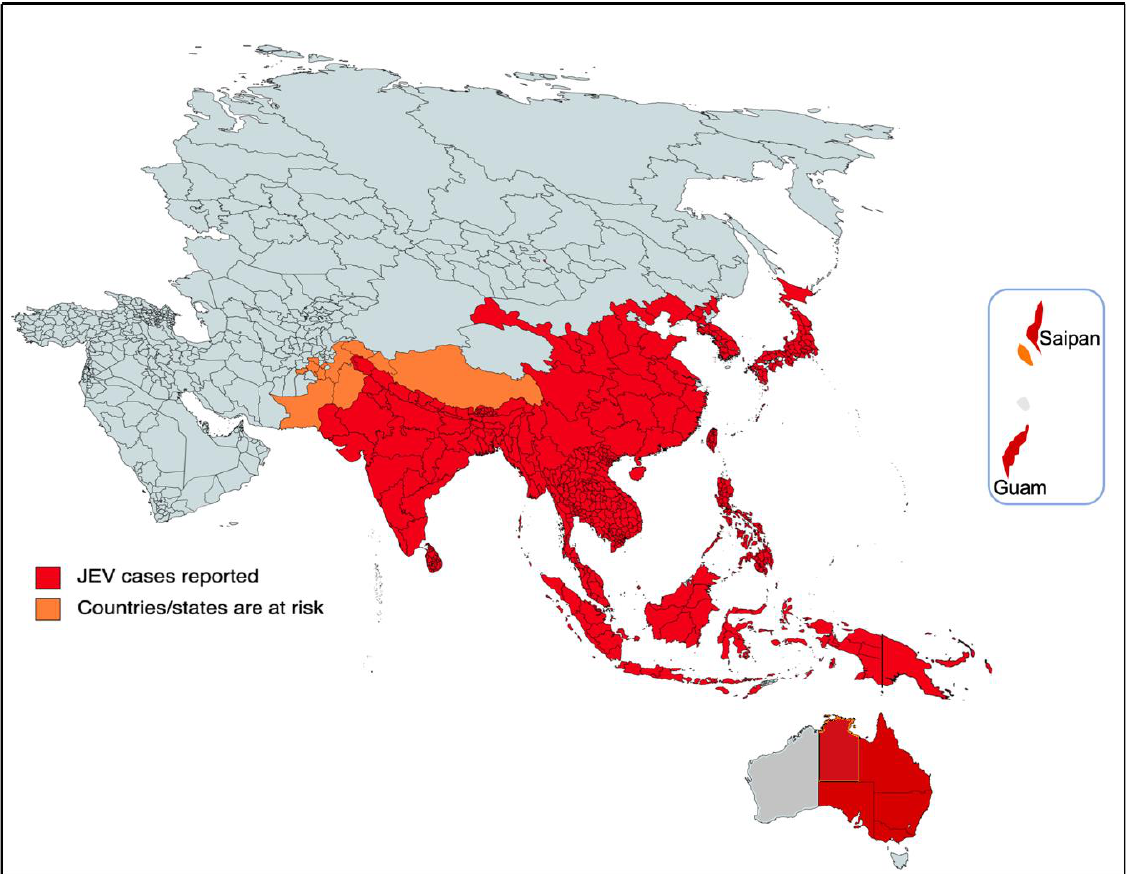
Figure 2. Geographical distribution of JEV. The red part of the focused Indo-Pacific geographical regions and countries indicates where active JEV cases have been reported since its outbreak. The orange color shows the areas that have the highest risk of JEV infection in the near future. The epidemiological data of JEV was modified from https://www.who.int/news-room/fact-sheets/detail/japanese-encephalitis (accessed on 26 December 2022).